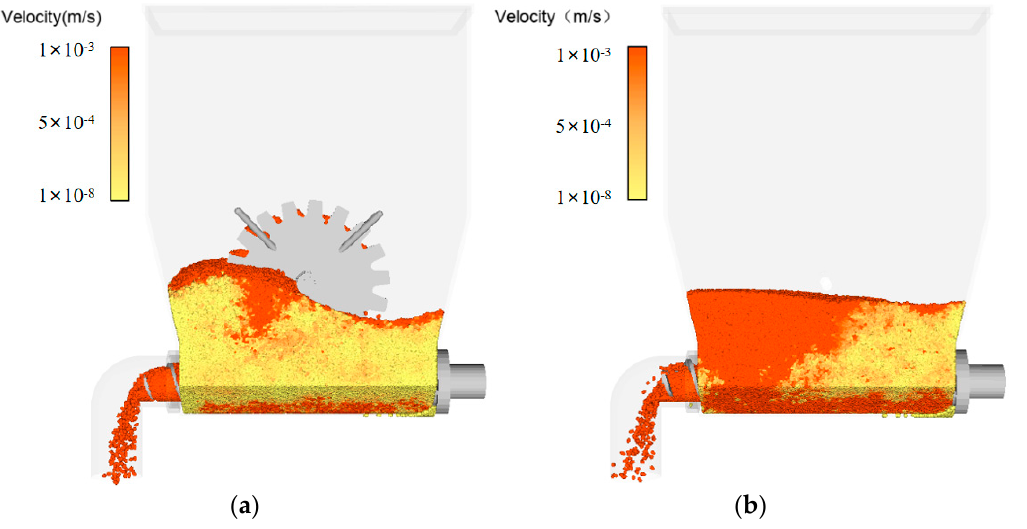
Figure 8. Seed velocity distribution in horizontal screw conveyor: ( a ) there is a stirring mechanism; ( b ) there is no stirring mechanism.